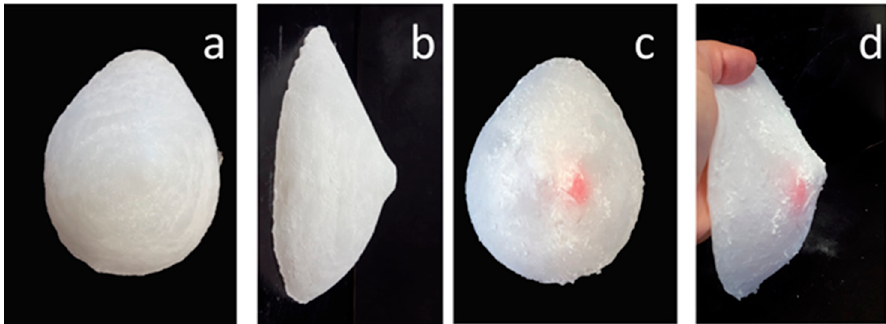
Figure 12. Breast phantoms—healthy breast ( a ) ( b ); and abnormal breast ( c ) ( d ).